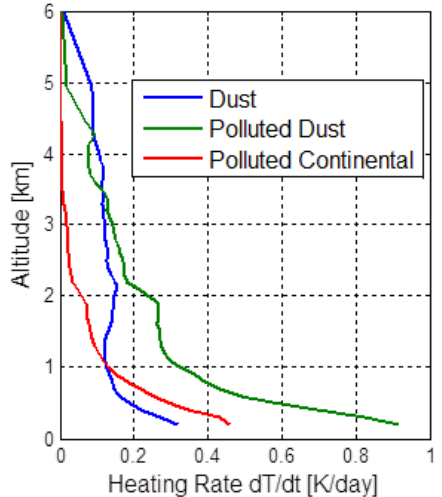
Figure 13. SBDART-derived heating rate profiles of dominant ab- sorbing aerosol types (dust, polluted dust and polluted continental) over eastern Mediterranean basin during summer